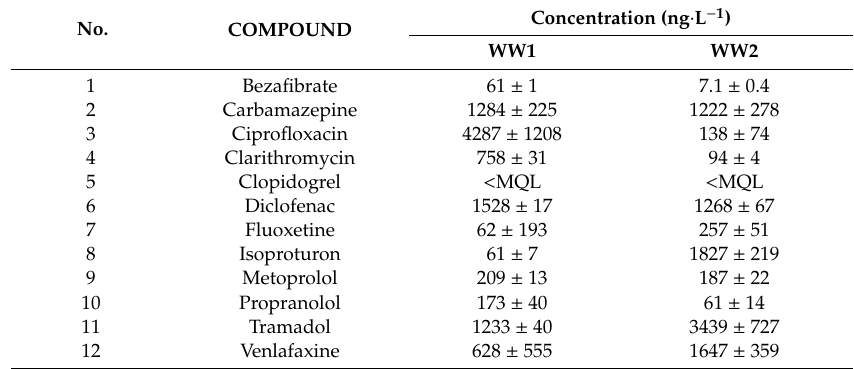
Table 1. List of numbered target pollutants found in wastewater (WW) samples and their concentrations.